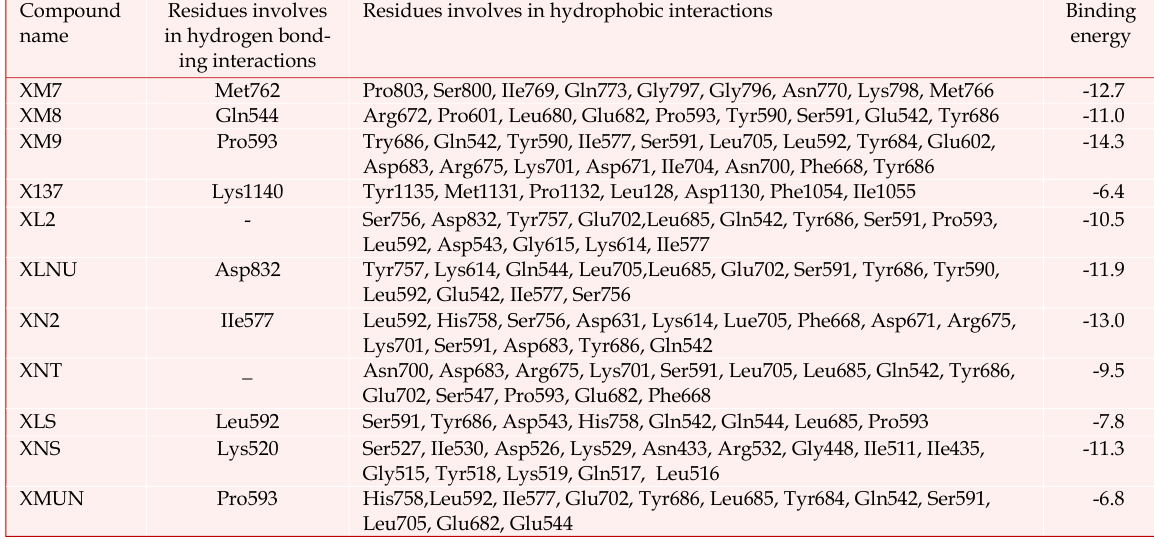
Solubility, drug likeness and drug score accounted by Osiris property explorer and with respect to binding energies of different novel substituted hybrid